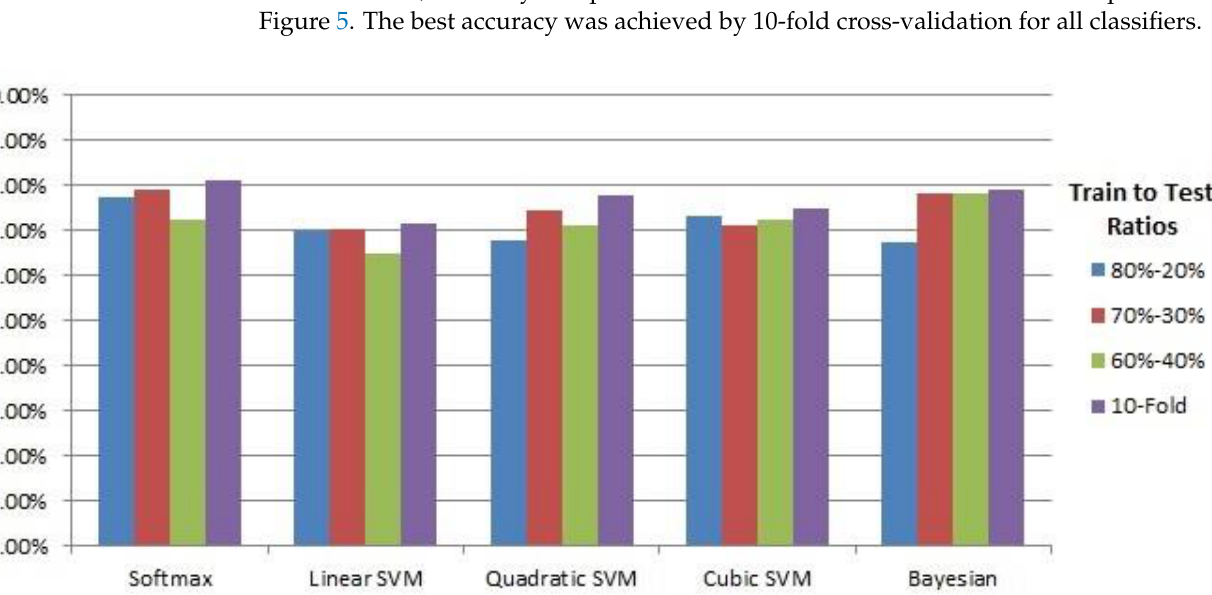
Figure 6. Confusion matrix using softmax classifier for original dataset. The results collected on contrast - enhanced images without augmentation are shown in Table 4. The softmax classifier outperformed other classifiers with a precision of 91.14%, a recall of 83.92%, an f - measure of 87.38%, and an accuracy of 89.23%, as pre- sented in Table 4. However, given that quadratic SVM performance is close to the soft- max, it cannot be disregarded. Moreover, comparing Tables 3 and 4, it shows that accu- racy, as well as other performance measures, improved after implementing the con- trast - enhancement technique and accuracy increased by nearly 9%. Hence, it is con- cluded that our proposed contrast - enhancement technique helped the model to general- ize better regarding WCE images.